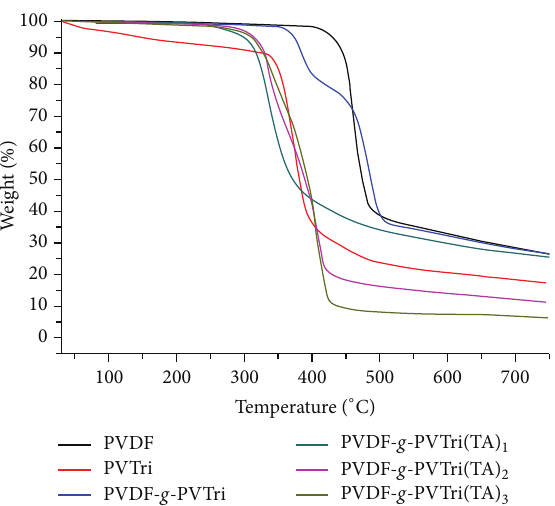
Figure 5: TG thermograms of PVDF, PVTri, PVDF- g -PVTri, and PVDF- g -PVTri-(TA) 𝑥 ( 𝑥 = 1.0 , 2.0 and 3.0) membranes at a heating rate of 10 ∘ C/min in inert